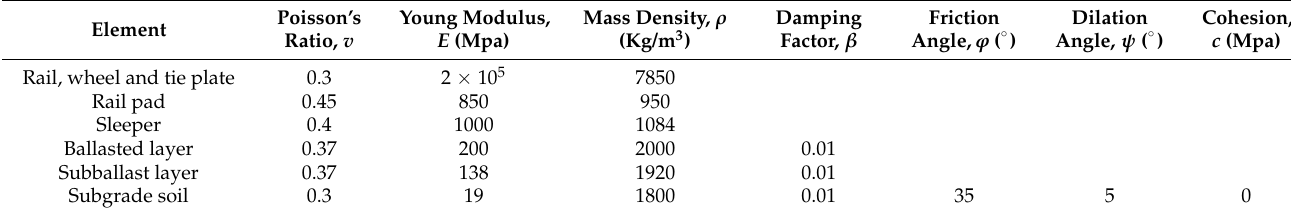
Table 2. Mechanical parameters of the track model.